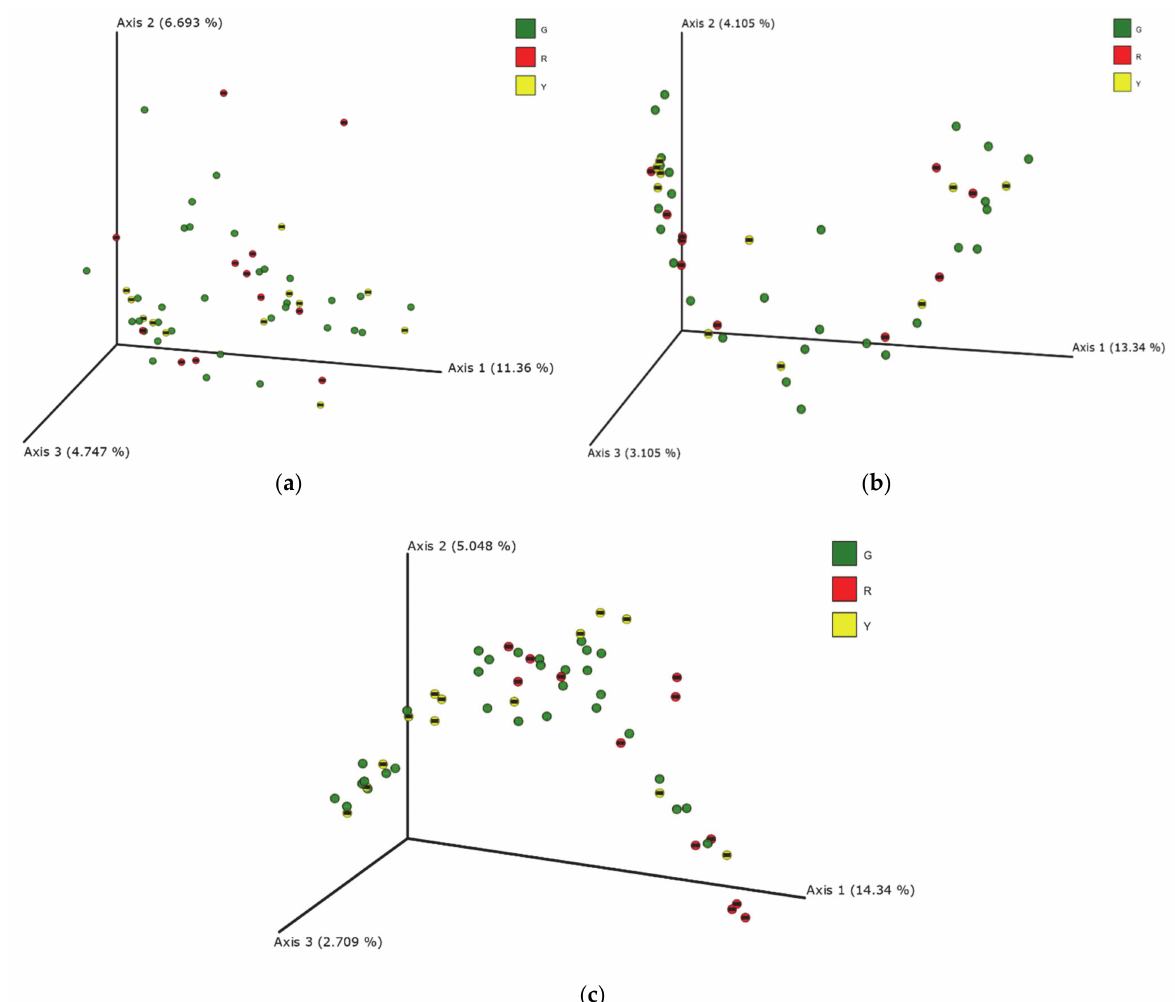
Figure 2. Principal coordinates analysis (PCoA) of the unweighted UNIFRAC distances of the microbial populations measured in feces ( a ), blood ( b ) and milk ( c ) sampled from lactating cows classified as healthy (G), at risk (Y) and with mastitis (R) on the basis of total somatic cell count (SCC) and differential somatic cell count (DSCC). PERMANOVA confirmed the differences between the G, Y and R groups of cows at p < 0.05 in milk samples. G = healthy, SCC/mL < 200,000 and DSCC ≤ 69.3%; Y = at risk, SCC/mL < 200,000 and DSCC > 69.3%; R = mastitis, SCC/mL >